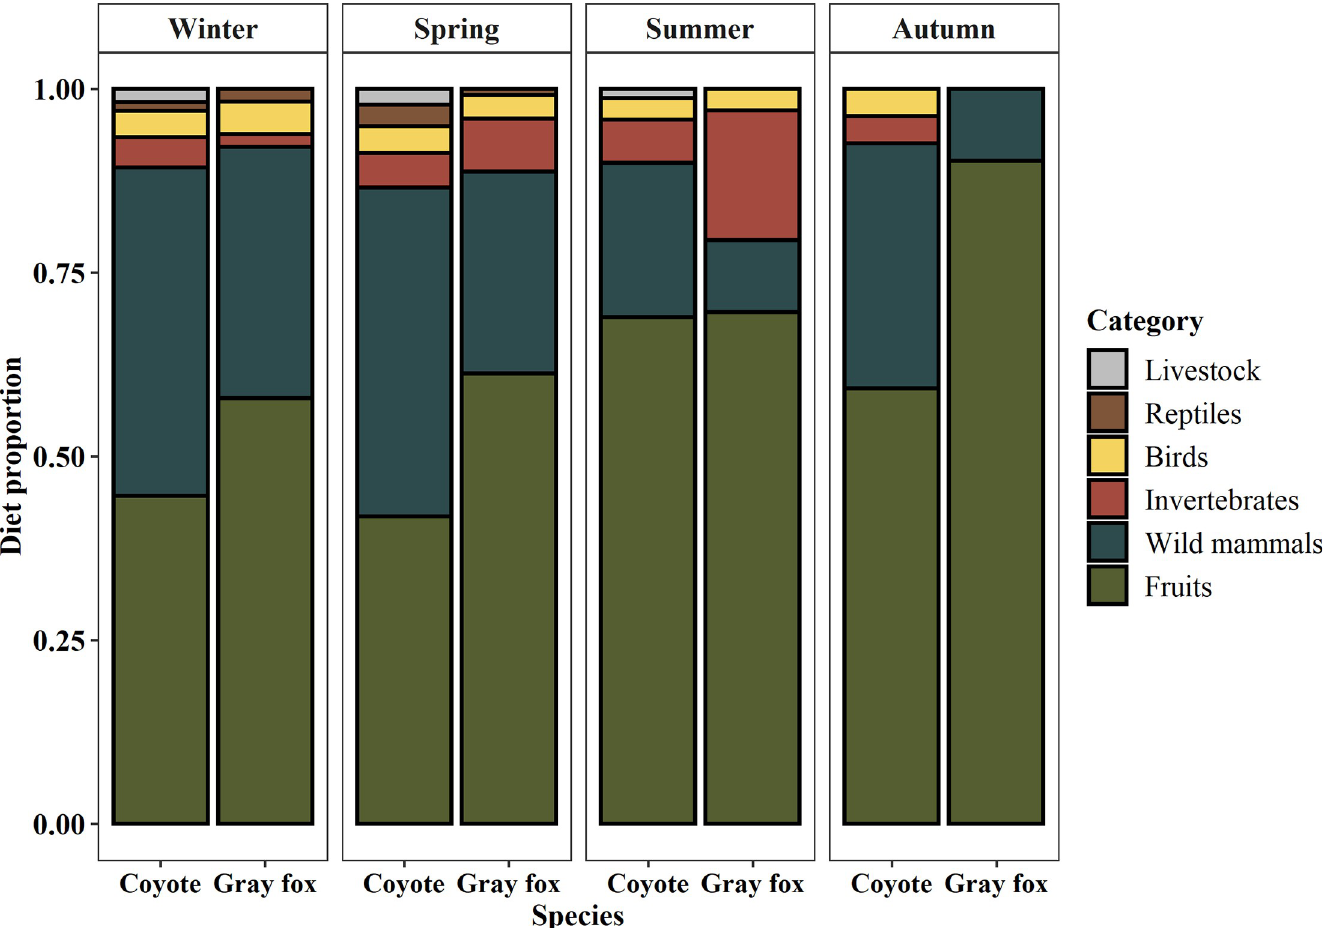
Fig 2. Seasonal occurrence of food items (expressed as proportion), by trophic categories, in the coyote and gray fox diets in the buffer zone of the La Michilı´a Biosphere Reserve, Durango, Mexico.